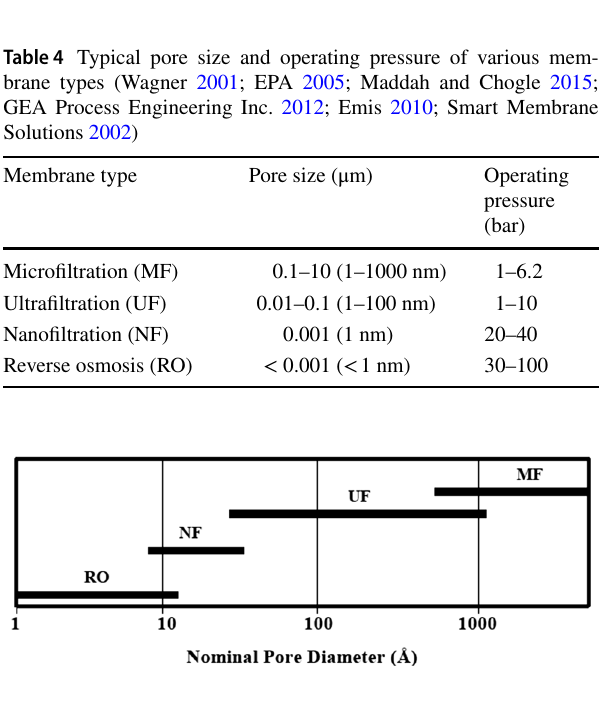
Fig. 2 Typical pore diameter of different membranes (Sagle and